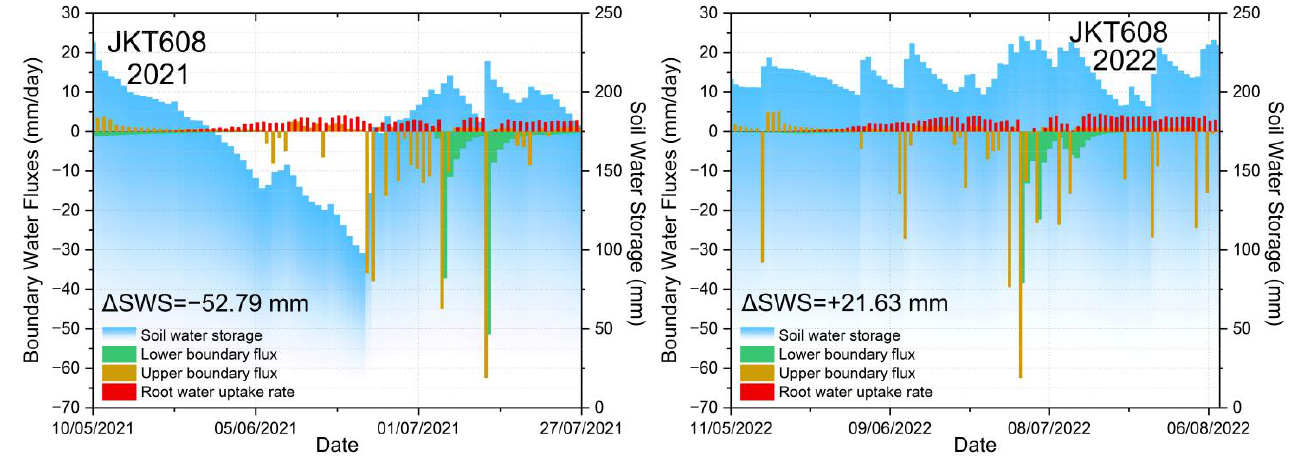
Figure 7. Changes in boundary fluxes and soil water storage in different plots.